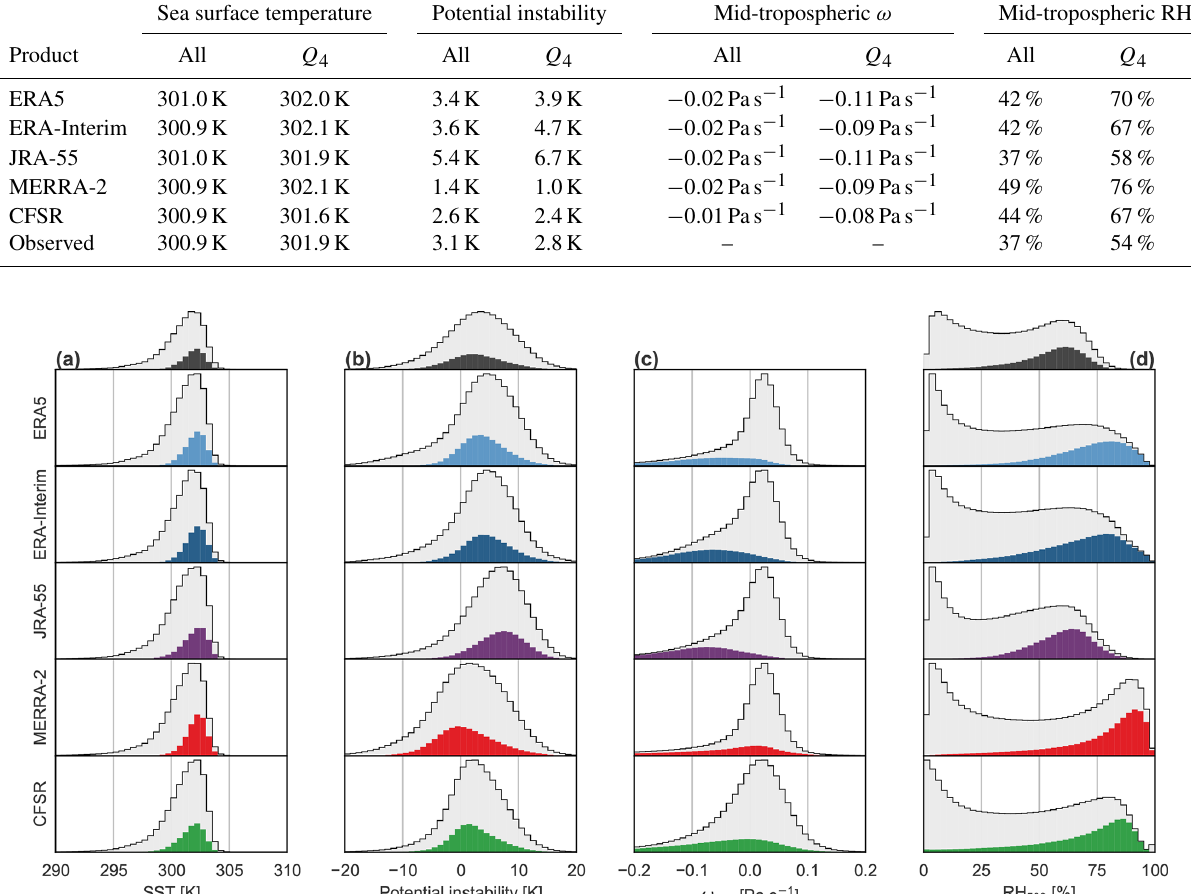
Figure 10. Histograms of (a) sea surface temperature (SST), (b) potential instability ( θ e , 850 − θ e , 500 ), (c) grid-scale vertical velocity in the middle troposphere ( ω 500 ), and (d) relative humidity in the middle troposphere (RH 500 ). Data are based on daily-mean products at 1 ◦ × 1 ◦ resolution from (top to bottom) ERA5, ERA-Interim, JRA-55, MERRA-2, and CFSR during 2001–2010 in the inner tropics (10 ◦ S–10 ◦ N). Observational estimates are shown along the top axis where available, with data from CERES SYN1Deg (LWCRE), OISST v2 (SST), and AIRS (potential instability and RH 500 ). Distributions that include AIRS data are for 2003–2010 rather than 2001–2010. Colour histograms show distributions for the top quartile of LWCRE in each data set (see Fig. 7). Mean values for each distribution are listed in Table